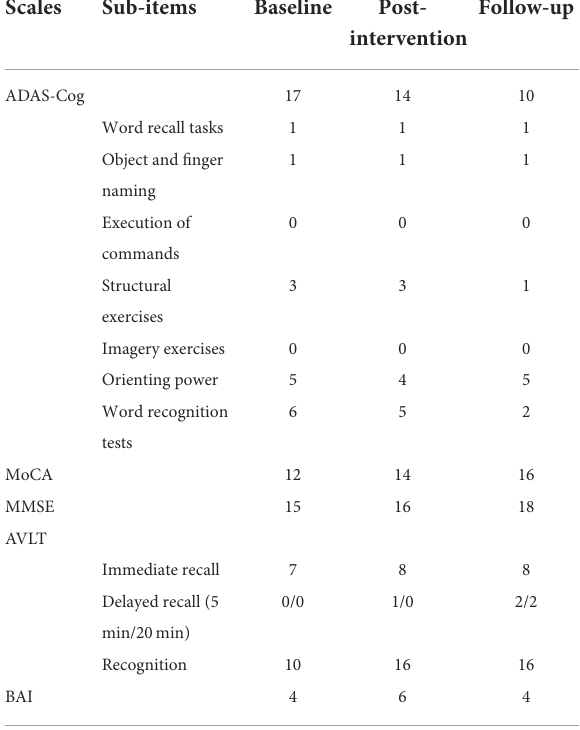
TABLE 1 Raw score of all